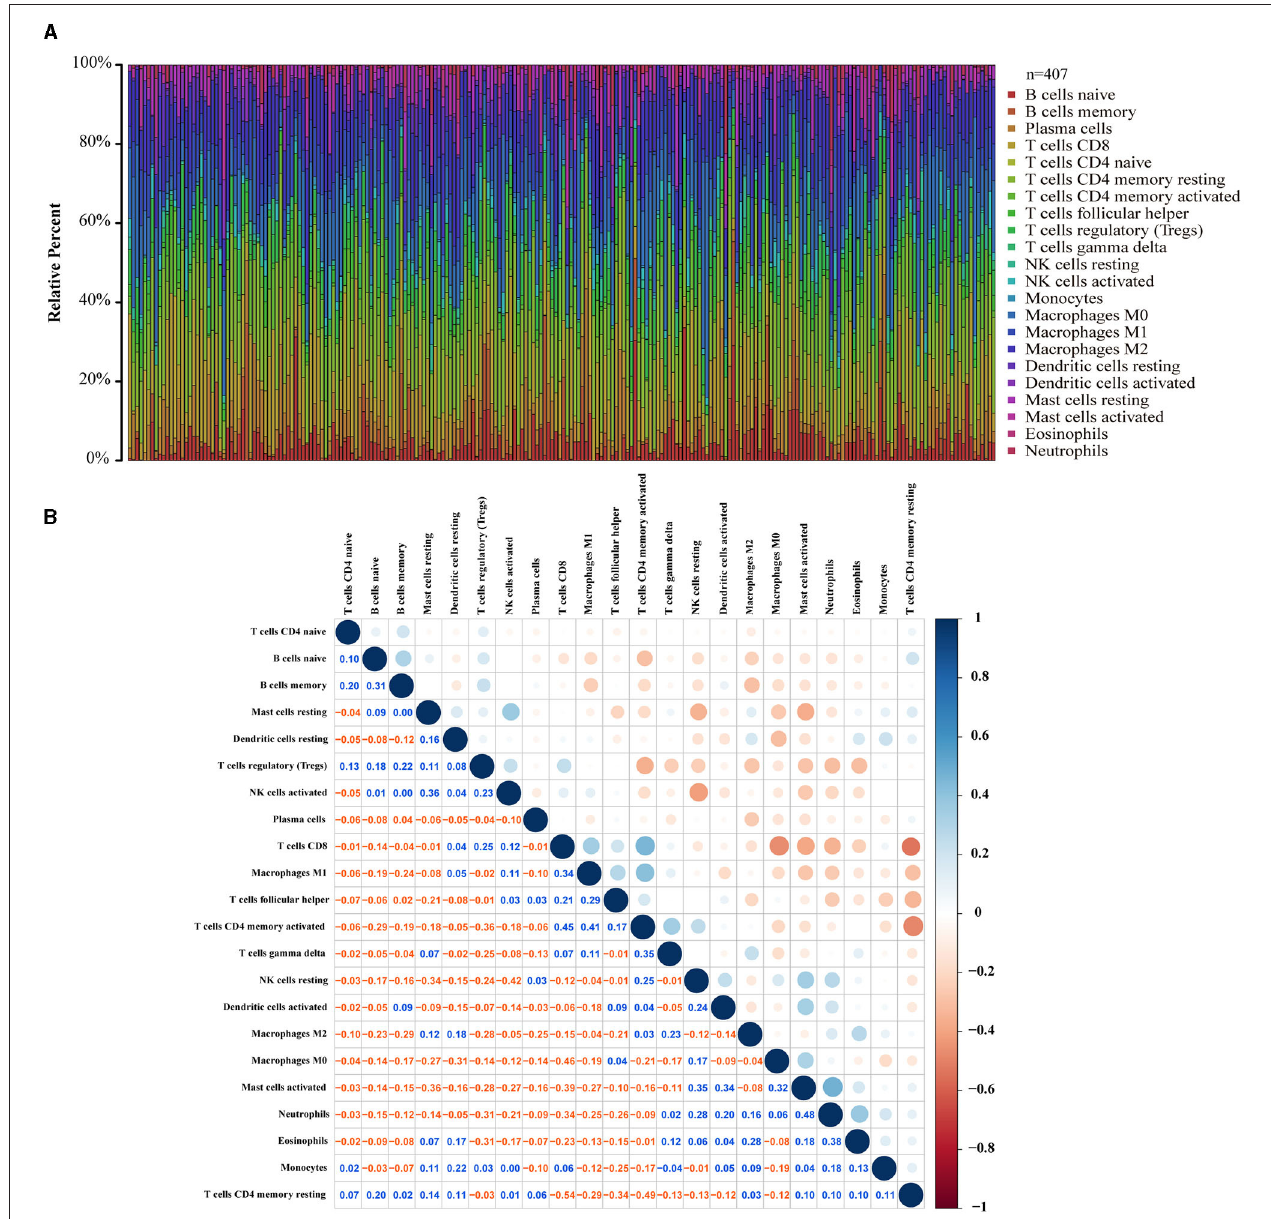
FIGURE 7 | TIC spectrum and correlation analysis in GC samples. (A) The bar graph shows the proportion of 22 TICs in the GC. (B) The heat map shows the correlation between 22 TICs (Pearson coefficient test). The number represents the p -value corresponding to the correlation between the two immune cells. The color depth of each box represents the corresponding correlation value between the two types of immune